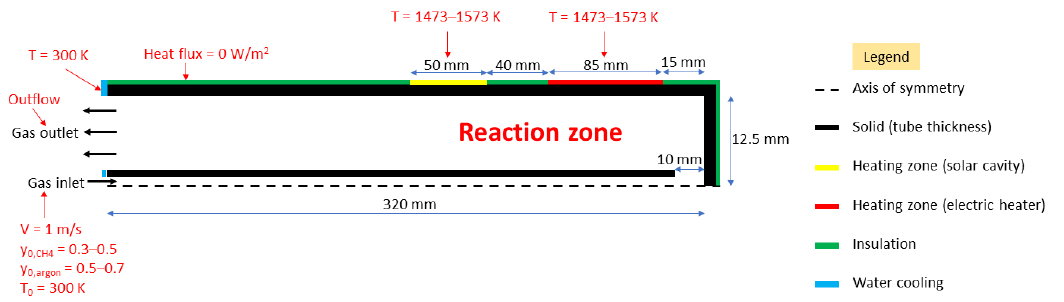
Figure 2. Simplified representative scheme of the 2D hybrid reactor geometry along with boundary conditions.